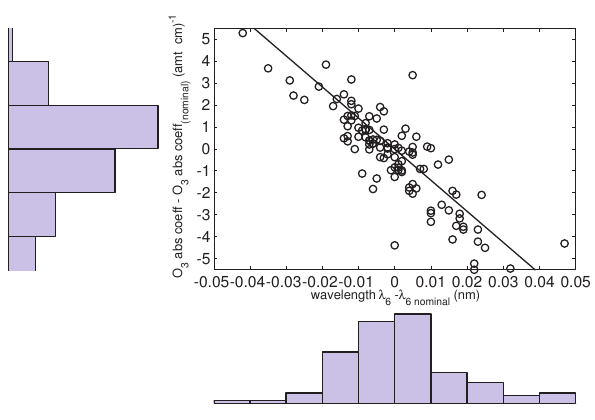
Fig. 3. Difference of the operative ozone absorption coefficient for each individual instrument to the nominal instrument vs. the differ- ence of the wavelength 6 (320nm) to the nominal value. The DXS is proportional to the wavelength